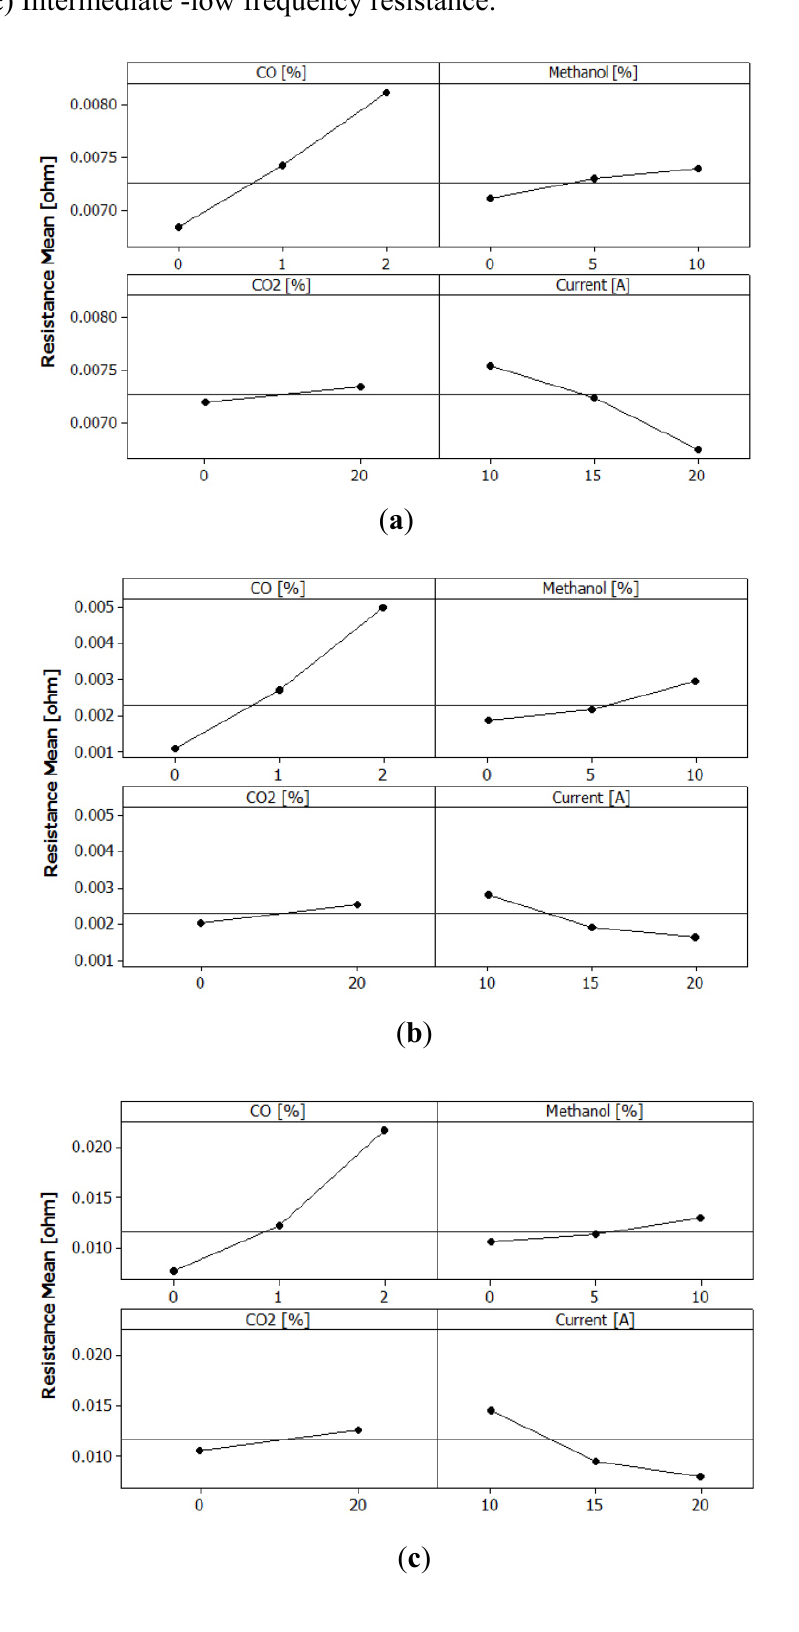
Figure 4. Main effects of each factor at 160 °C. ( a ) Ohmic resistance; ( b ) High frequency resistance; ( c ) Intermediate -low frequency